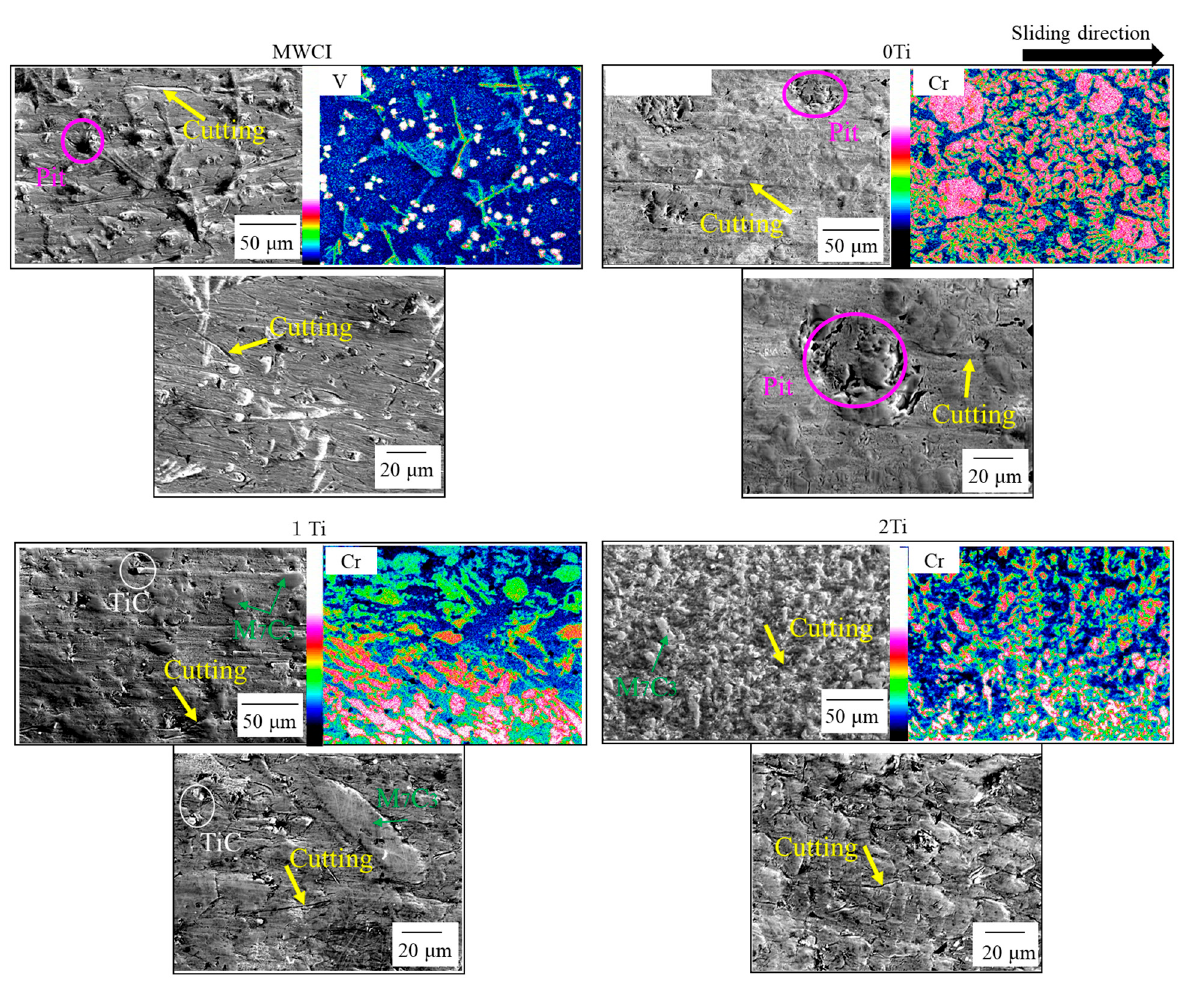
Figure 11. The worn surface of each material after the test with the silica sand ϕ 300 μ m observed via high magnification on SEM-EDS equipment.